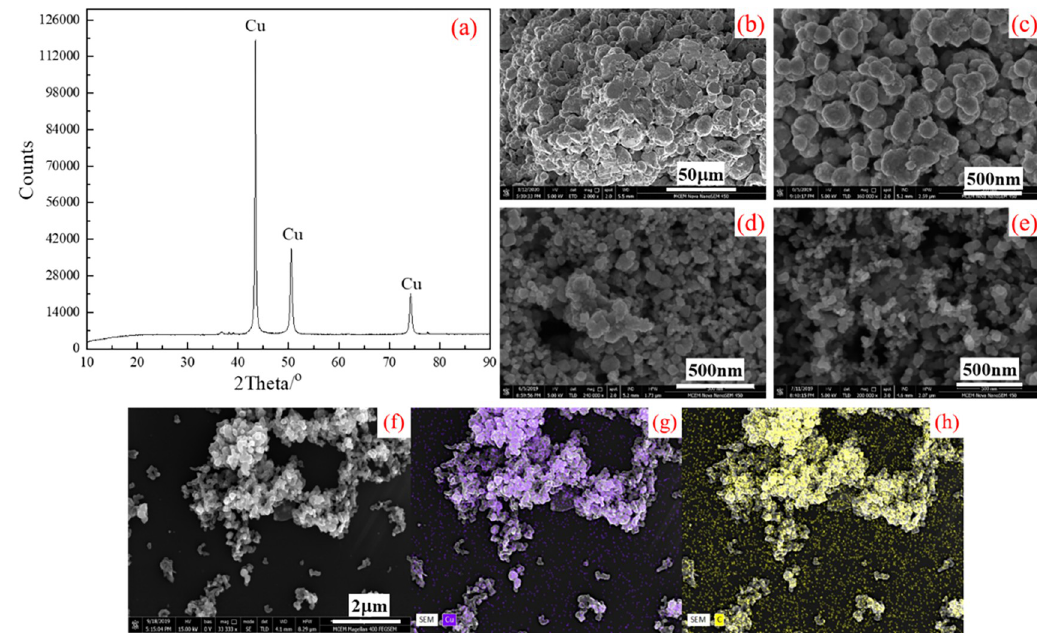
Fig 4. Characterization of various copper particles (a) typical XRD pattern of CCE; (b)-(e)SEM images of (b) commercial Cu (c) prepared Cu (d) CCD powder (e) CCE powder; and (f)-(h) SEM image and elements mapping of CCD